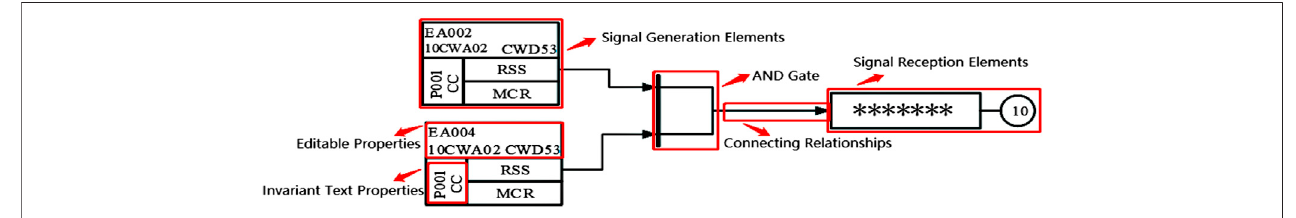
FIGURE 1 | The part of the industrial control logic diagram